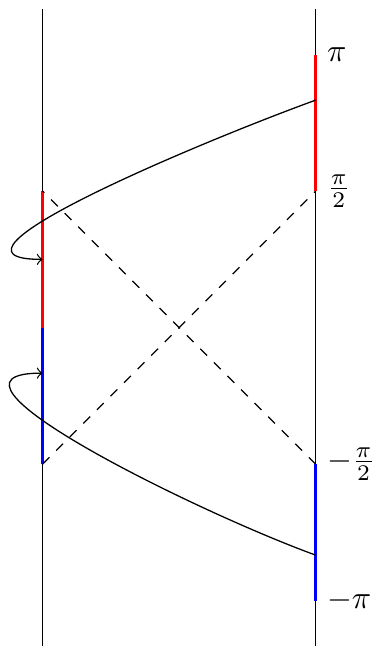
Figure 1 . In this figure it is shown that how one may map the support of the global boundary representation of annihilation/creation operators to the support of the left and right AdS/Rindler representations. This is done using the antipidal map. This maps the right boundary region between π and π to the red region in the left boundary (between 0 and π ). The right boundary 2 2 region shown in blue (region between − p and − π ) is likewise mapped to the region shown in blue in the left boundary (between 0 and − π 2